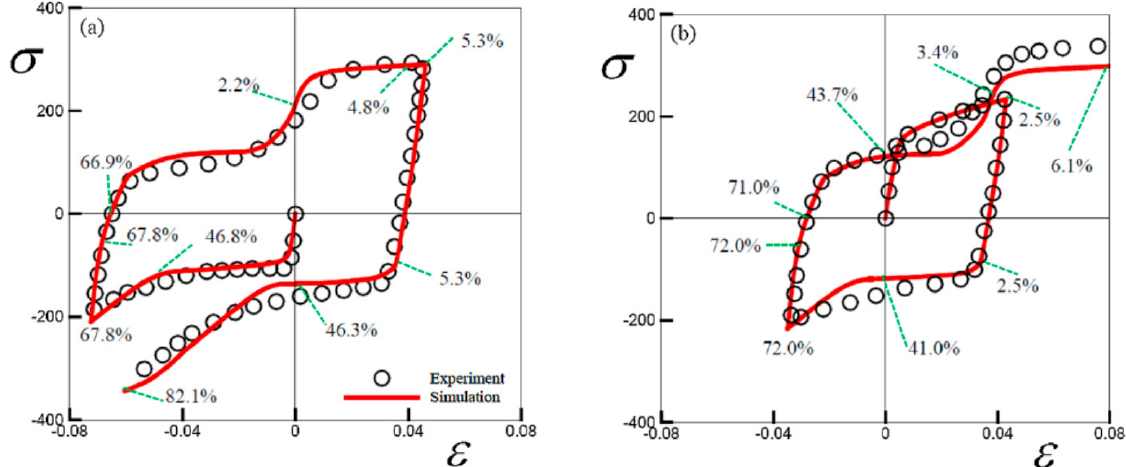
Figure 10. Comparison of predicted cyclic response of AZ31B Mg alloy versus the experimental data subjected to different loading paths of: ( a ) Uniaxial compression ‐ tension ‐ compression, ( b ) uniaxial tension ‐ compression ‐ tension. The twin volume is predicted by simulation and demonstrated at different strains (After H. Wang et al. [90]).